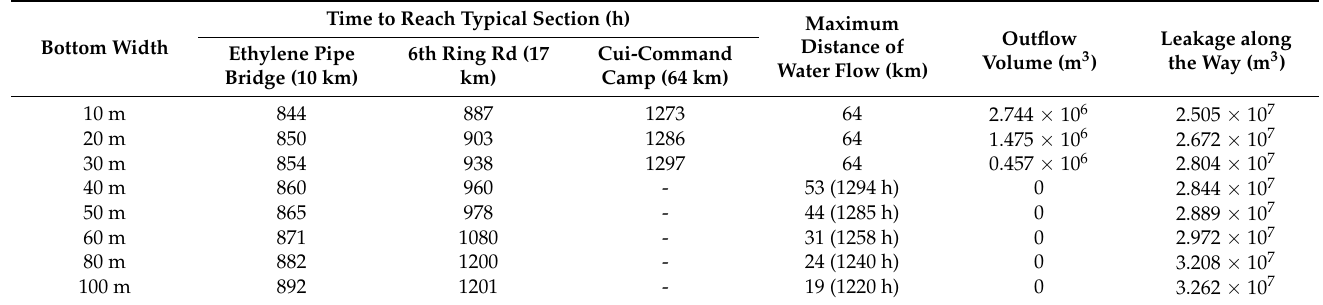
Table 7. The results of modelled trapezoidal sections under different bottom widths.